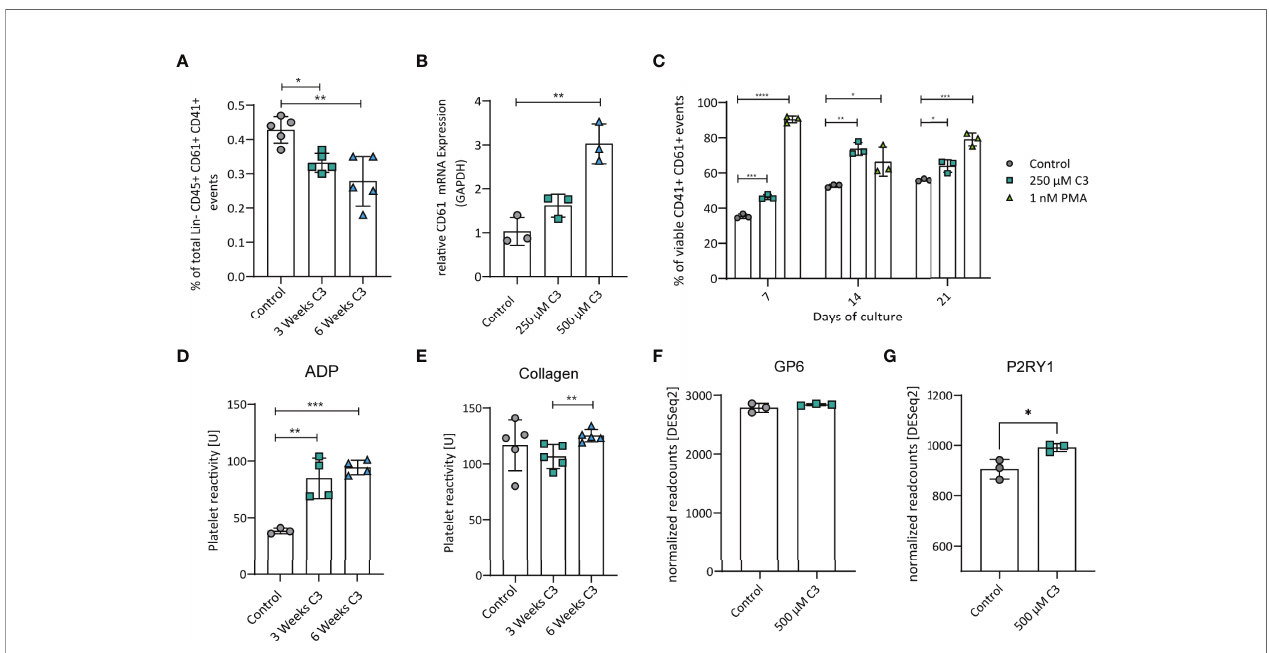
FIGURE 2 | C3 reduced megakaryocyte numbers in vivo but promoted maturation in vitro and increased reactivity of platelets to ADP after three or six weeks of C3 treatment but not to collagen. (A) Total percentage of Megakaryocytes in the bone marrow after three and six weeks of C3 treatment. (B) Gene expression CD61 in Meg-01 cell line after treatment with 250 µM and 500 µM C3. (C) Percentage of viable CD41 + CD61 + Meg-01 after treatment with 250 µM C3 or 1 nM PMA as a positive control after 7, 14 or 21 days of treatment in vitro . (D) Platelet reactivity to ADP after three or six weeks of C3 treatment. (E) Platelet reactivity to collagen after three or six weeks of C3 treatment. (F) Gene expression of GP6 in Meg-01 cells between control and 500 µM C3 treatment. (G) Gene expression of P2RY1in Meg-01 cell between control and 500 µM C3 treatment. Data are expressed as the mean ± sd. Statistical difference was determined by Two-way ANOVA, Student ’ s t-test and One-way ANOVA. *p < 0.05; **p < 0.01; ***p < 0.001; **** means p <